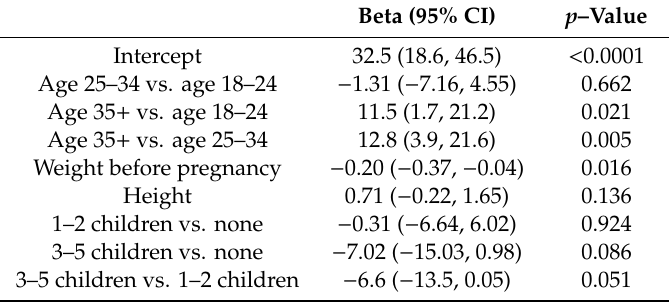
Table 4. Association of GWG with age, weight before pregnancy, height, and number of